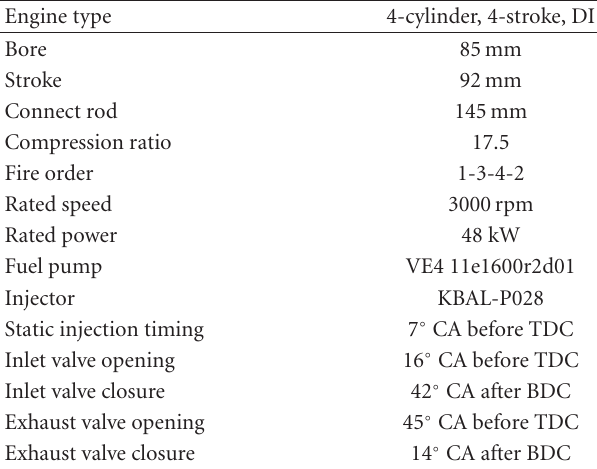
Table 1: The basic data of the